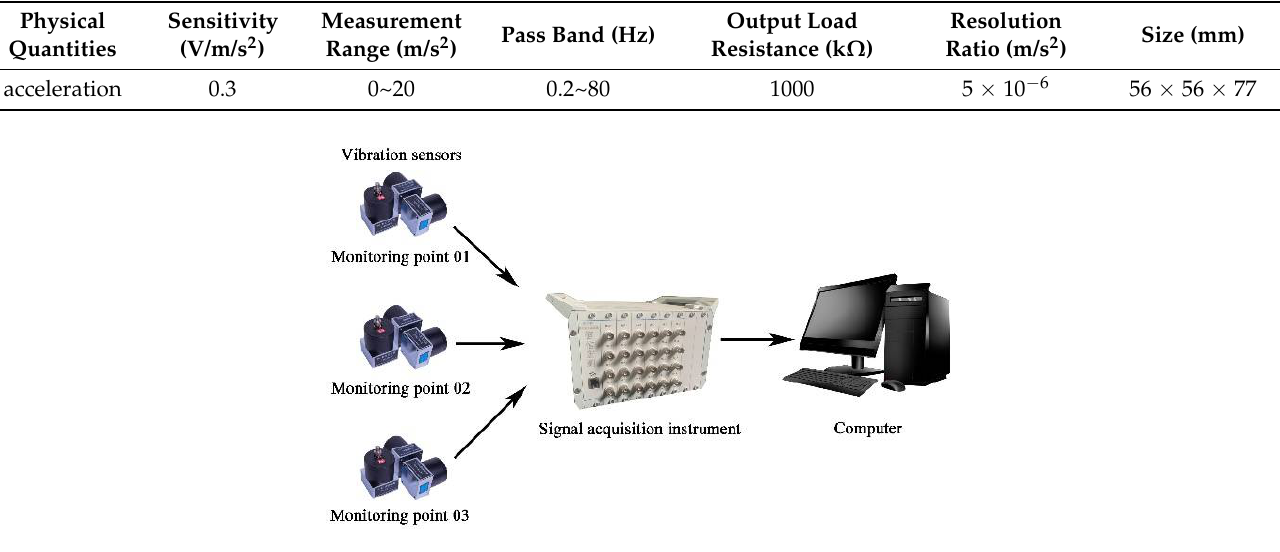
Table 1. Technical parameters of the vibration sensor (JX941).